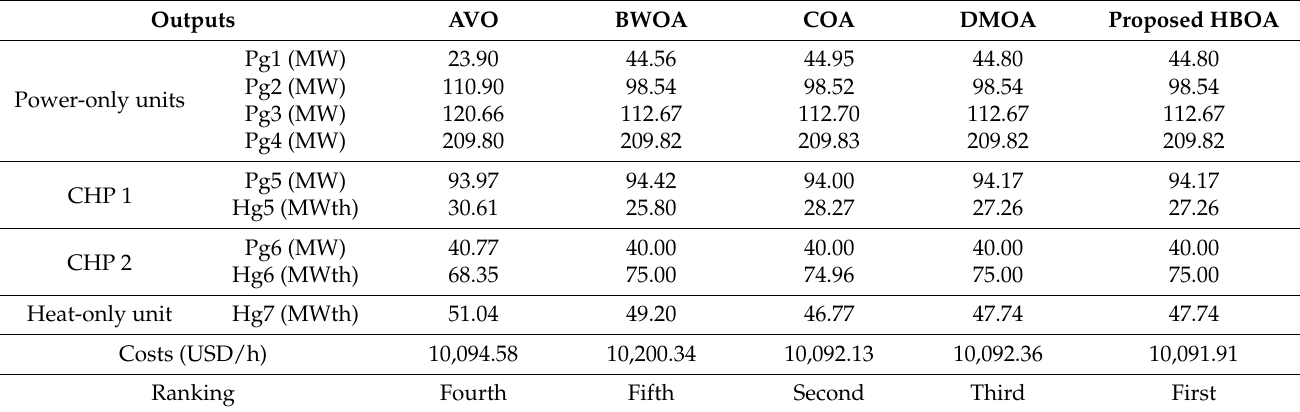
Table 3. Results of the proposed HBOA and the AVO, DMOA, COA, and BWOA of Case 1 for the first loading